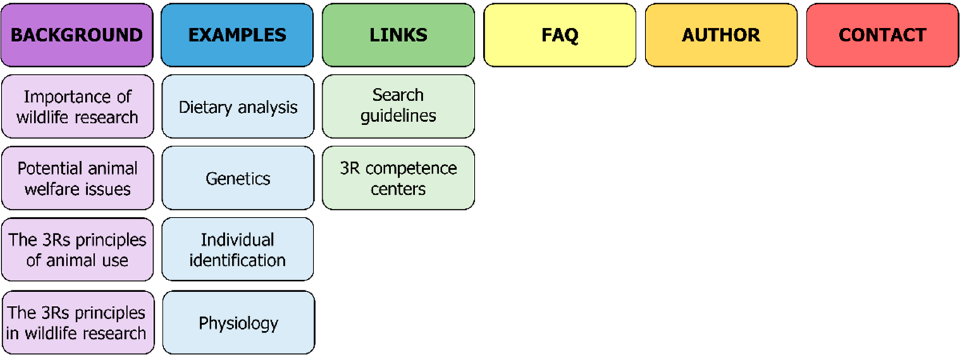
Figure 1. The current content structure of the 3Rs Principles in Wildlife Research website (https://3RsWildlife.info, accessed on 15 May 2021). //3RsWildlife.info, accessed on 15 May